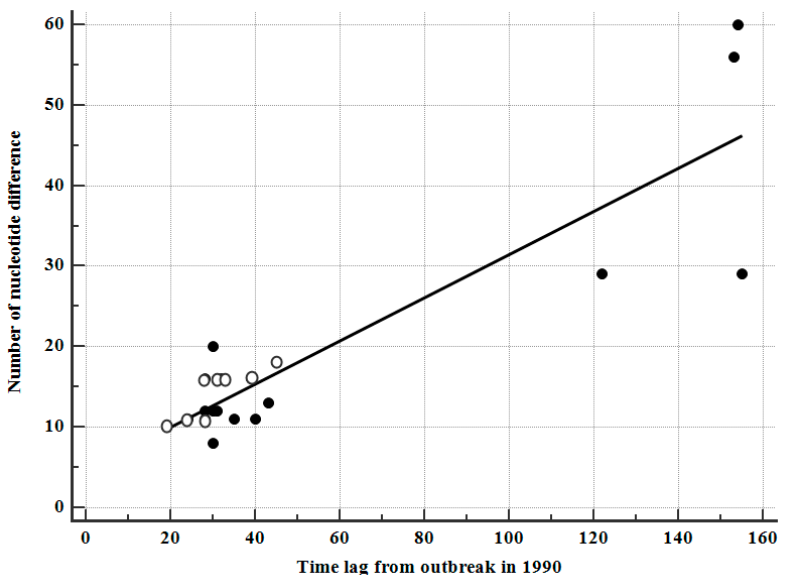
Figure 2. Correlation of the time lag (months) between the outbreak (around January 1990) and sampling and the number of nucleotide differences in the 20 HPs, compared to corresponding plasma donors. Four patients (HPs 9, 15, 19, and 20) who provided serum samples after 2002 exhibited the most differences ( ≥ 29). The correlation coefficient, γ , was 0.89 ( p < 0.0001). Eight hemophiliacs infected with HIV-1 originated from plasma donor O and 12 hemophiliacs infected from plasma donor P are indicated with white and black circles, respectively.